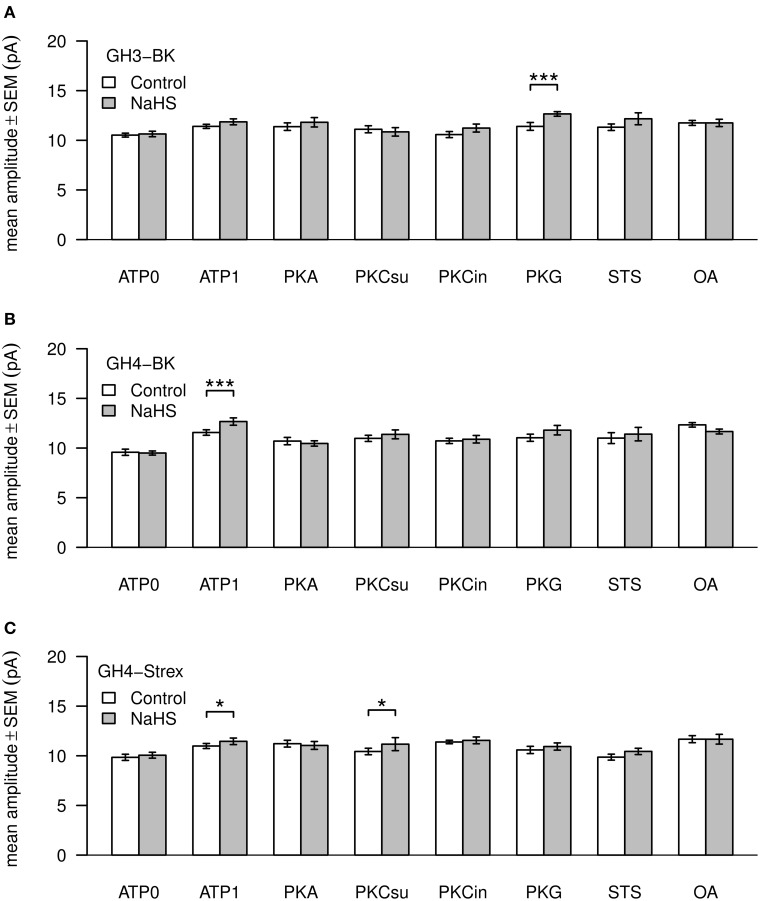
Mean values of BK channel amplitudes. Three types of channels—GH3-BK (A), GH4-BK (B), and GH4-STREX (C) cells were investigated. Bar graphs show amplitude values in pA under control conditions (left bars, white) and after extracellular application of 300 μM NaHS (right bars, gray). All drug concentrations were the same as depicted in Figure 3. Significant *0.05 > p > 0.01; most significant ***p < 0.001.